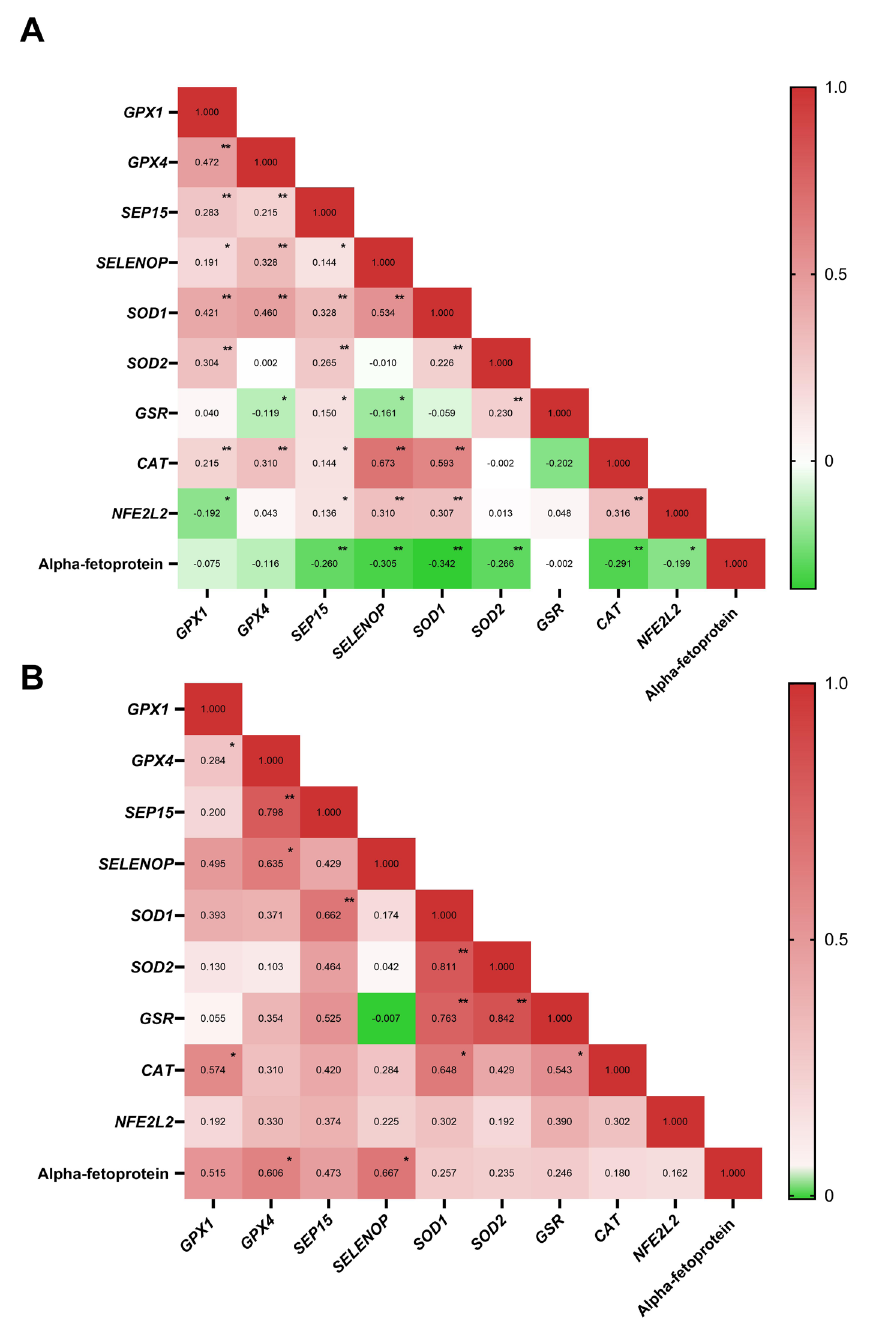
Figure 2 – Spearman correlation analysis. (A) Spearman correlation coefficients (r) for gene expression levels in TCGA tumoral samples and clinical data. (B) Spearman correlation coefficients (r) for gene expression levels in ISCMPA tumoral samples. *p<0.05,